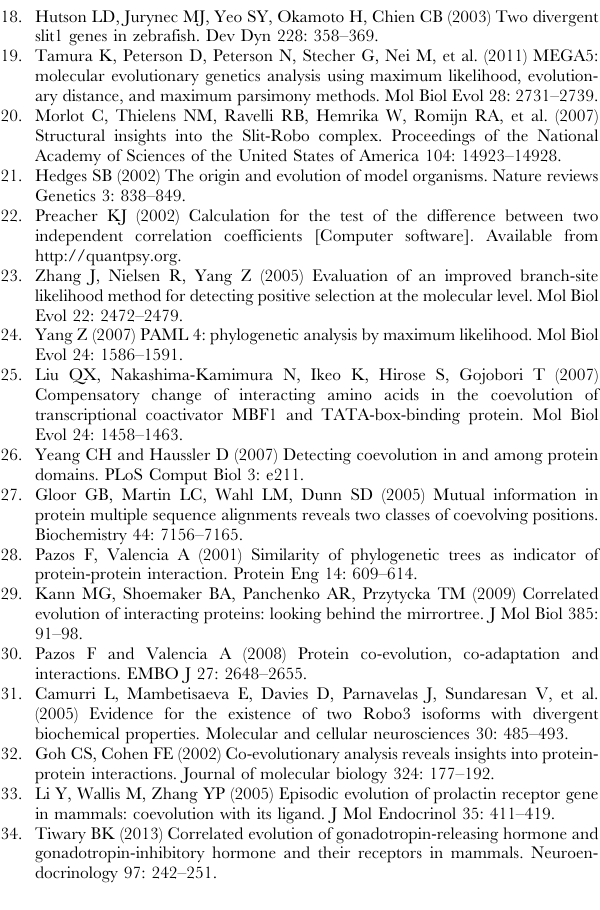
Table S6 Parameter estimates of branch-site models for slit and robo1 in insects. (XLS) Table S7 Parameter estimates of branch-site models for slit1 , slit3 , robo1 and robo2 in